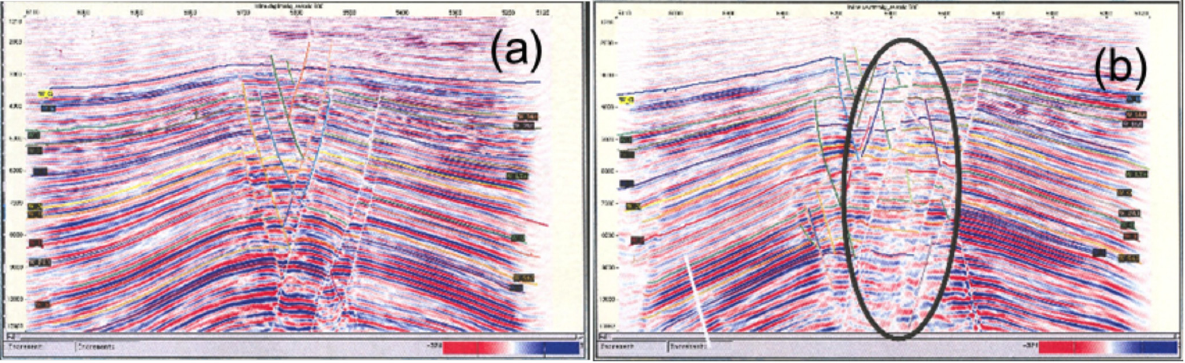
Figure 1. Gas masking effect: (a) perfecting imaging with no shallow gas cloud; (b) poor imaging with gas leakage due to poor sealing of hydrocarbon